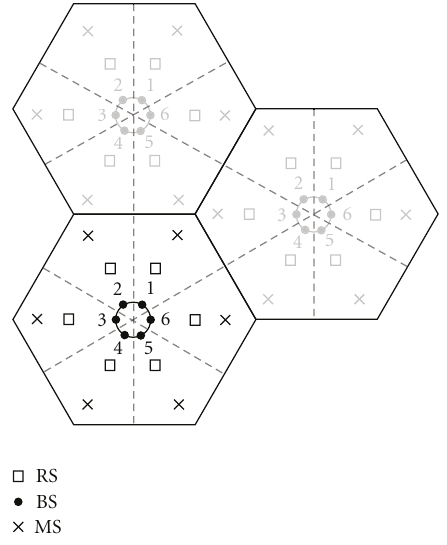
Figure 3: Base system model for two-way relaying. Each sector contains one single-antenna amplify-and-forward relay, and there is no coordination between cells. The sectors in a given cell may cooperate to decode the uplink signals from the users in the cell but do not cooperate in the